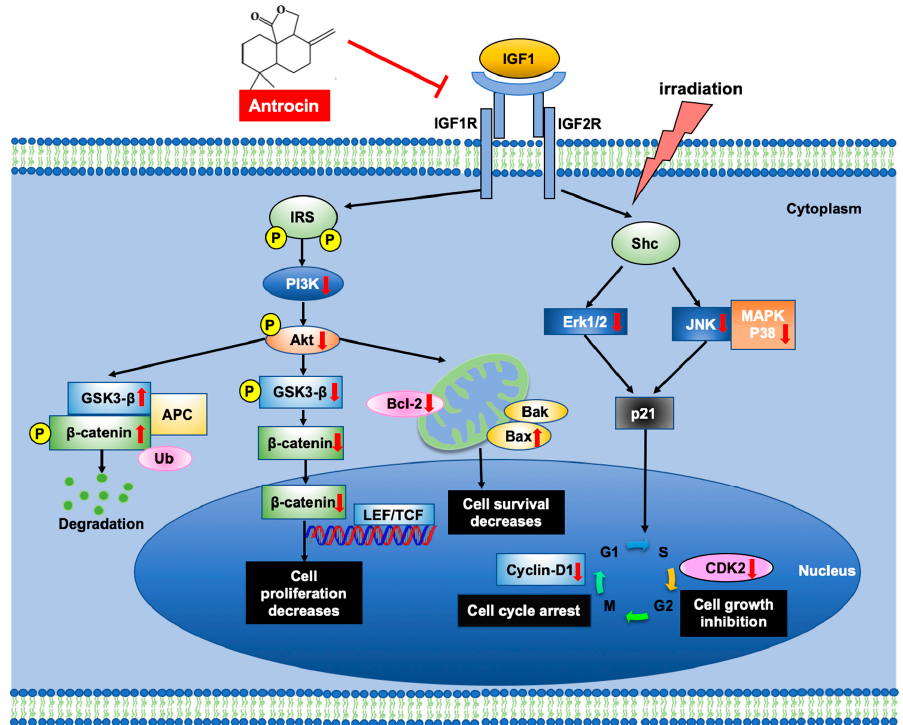
Figure 8. Proposed mechanism of action for antrocin-induced sensitization to radiotherapy in radioresistant PCa cells. IGF-1 binds to IGF-1R and induces IRS/Shc phosphorylation, which leads to the activation of PI3K/AKT and MAPK signaling. Co-treatment of cells with antrocin and radiation inhibits IGF1-induced activation of the PI3K/AKT and MAPK pathways, effectively sensitizing PCa cells to radiotherapy. IRS: insulin receptor substrate; Shc: src homology/collagen; LEF: lymphoid enhancer factor; TCF: transcription factor; Ub: